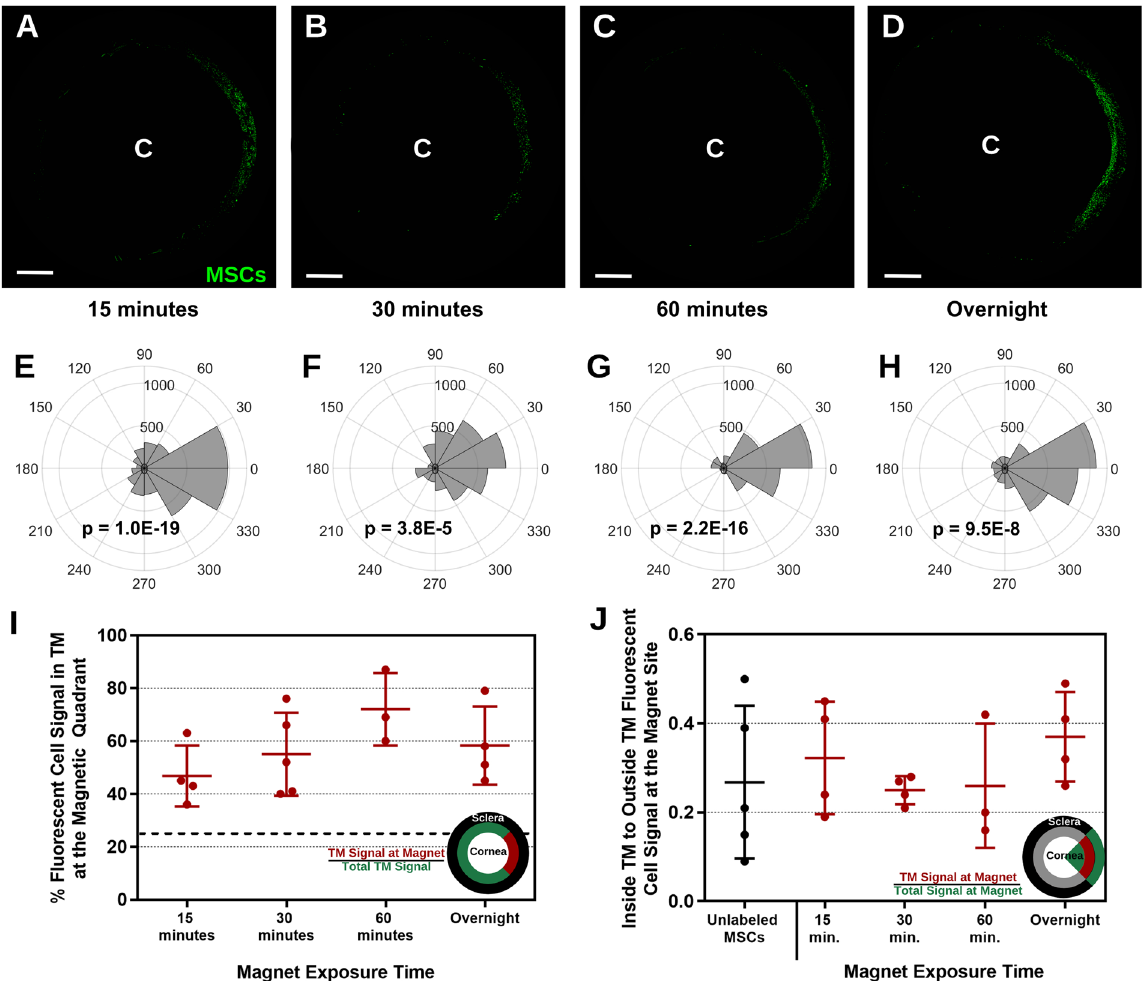
Figure 3. Effect of Magnetic Field Exposure Time on Steering of 200 nm PBNC-MSCs to the TM. (A–D) Representative en face micrographs of the anterior region of the eye after MSC delivery. Bar magnets were placed near the limbal region overnight (Fig. 2B). “C” denotes the approximate center of the cornea. Note that the image has been masked so that only signal from the putative TM region is shown (see Methods). Scale bars denote 2 mm. (E–H) The polar histograms illustrate the total fluorescence intensity within the TM region (plotted on the radial coordinate, in arbitrary units) for 30° sectors around the eye. p-values were calculated using Kuiper’s V test to assess if distribution was non-uniformly skewed towards the center of the magnet location (0°). (A,E) 15 minutes (n = 4 eyes), (B,F) 30 minutes (n = 5 eyes), (C,G) 60 minutes (n = 3 eyes), and (D,H) overnight (n = 4 eyes) magnet exposure experiments are shown. (I) Percentage of fluorescent cell signal in the TM in the magnet region, defined as the wedge extending from 45° to − 45°. Dotted line indicates the value that would be expected if there were uniform cell delivery to the entire TM circumference (25%). (J) Fluorescent signal in the TM region relative to the fluorescent signal not in the TM region, both within the magnet site, i.e. within the sector extending from − 45° to + 45°. Individual data points are shown with central bars indicating mean values and error bars denoting standard deviation. All comparisons between groups were not significant (p > 0.05) as determined by one-way ANOVA with post hoc Tukey